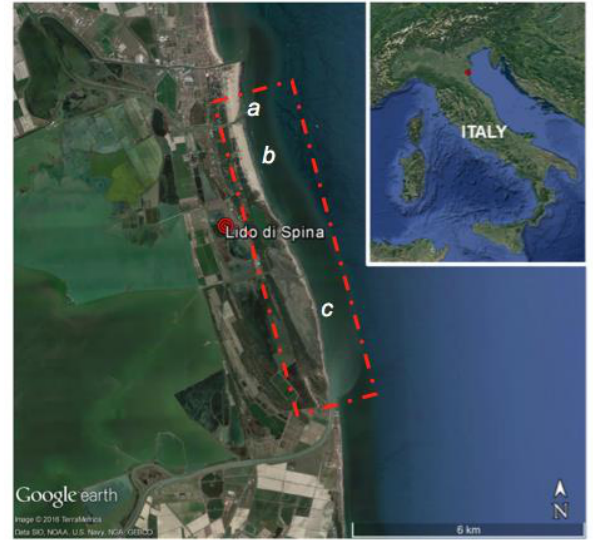
Figure 1. Wider view of the study area of Lido di Spina (images from Google Earth [25]; privately processed). The plot also shows the location of areas of interest: Logonovo channel at Lido degli Estensi (zone a ), Lido di Spina (zone b ), and Gobbino channel (zone c ).